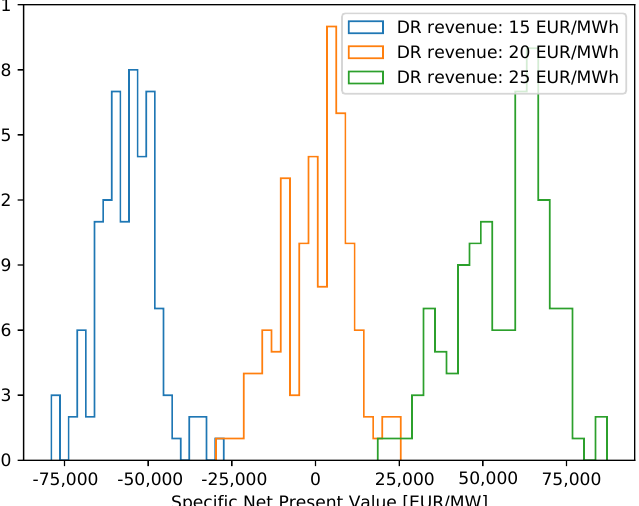
Figure 13. Frequency distribution of the specific net present values of the aggregated DR units per grid